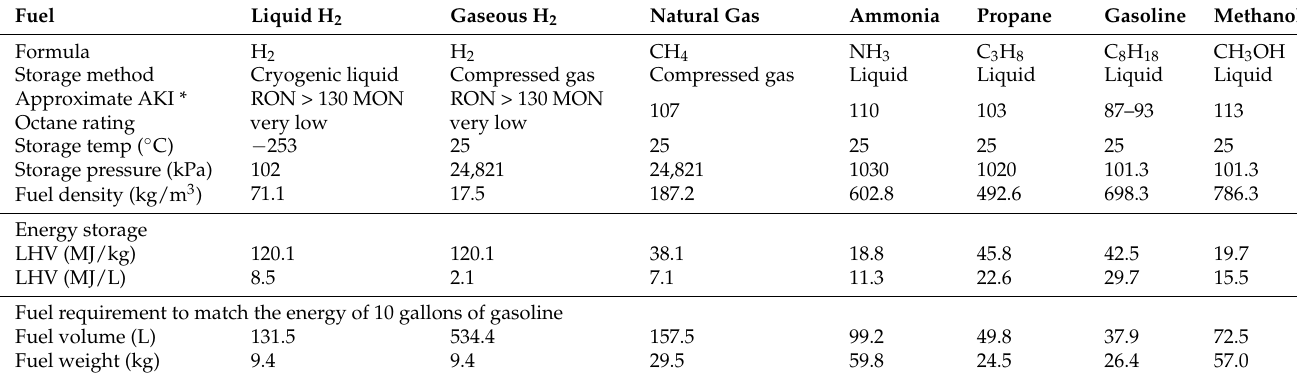
Table 2. Comparing hydrogen properties with other fuels. Reprinted with permission [23,24].